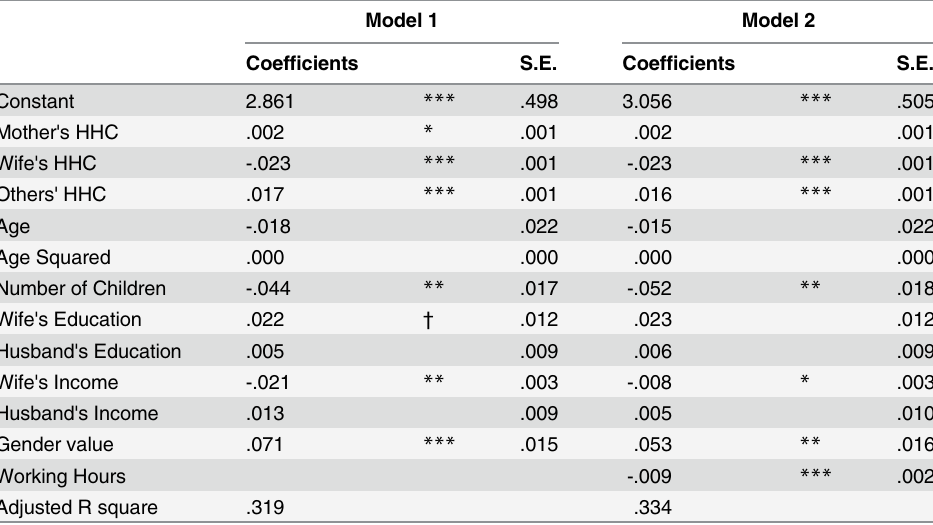
Table 4. Determinants of “ Perception of Fairness ” on Household Division of